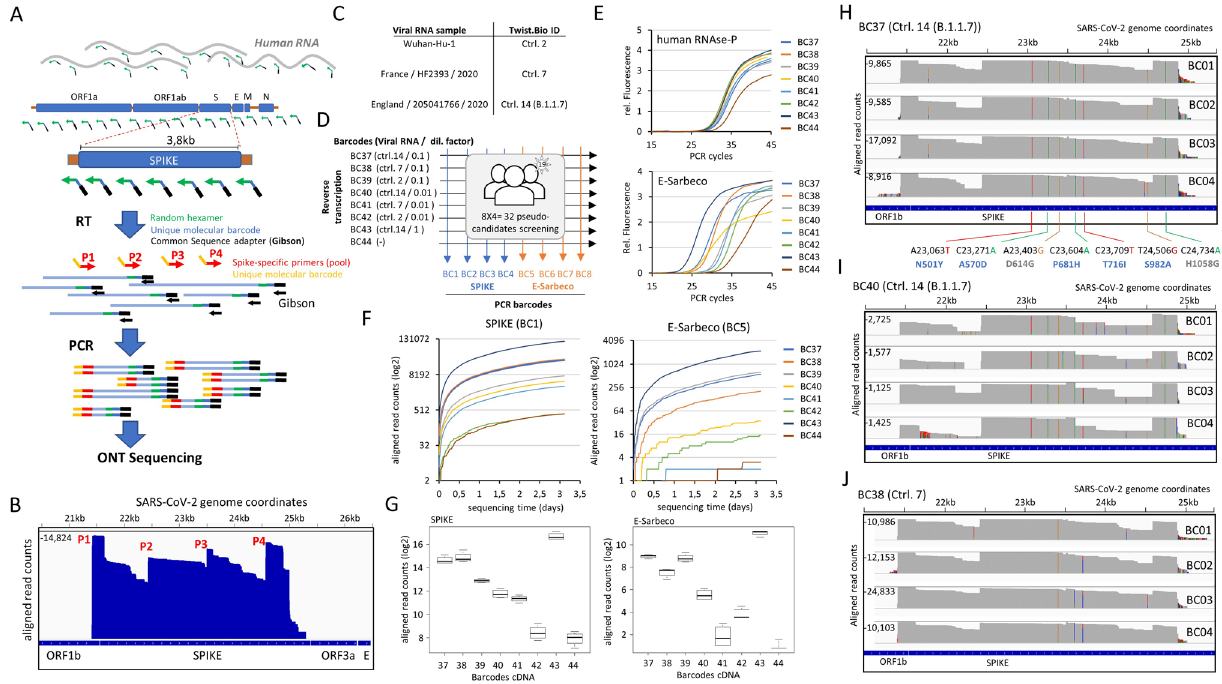
Figure 4. SARS-CoV-2 variants tracking within the SPIKE gene. ( A ) Scheme illustrating the SPIKE targeted strategy for variants tracking with Oxford Nanopore technology (ONT) sequencing. Reverse transcription is performed with random hexamer primers presenting unique molecular barcodes and the Gibson adapter sequence. This approach, allows to generate cDNA products of variable length covering the whole viral but also the human genome. Barcoded cDNA samples are PCR amplified with four SPIKE-specific primers (each of them including a common molecular DNA barcode and spaced by ~ 1 kb distance) and one Gibson primer targeting the adapter sequence introduced during reverse transcription. For facilitating the assay, all four SPIKE and Gibson primers are used within an equimolar pool. PCR amplified samples are analyzed by Oxford Nanopore MinION DNA sequencing. ( B ) Genome browser view displaying the aligned read counts obtained after ONT sequencing. Location of each of the SPIKE-targeting primers (P1-P4) is displayed and corresponds to regions presenting the highest read counts within the SPIKE gene. ( C ) Summary of the used synthetic SARS-CoV-2 viral RNA samples, corresponding to the Wuhan-Hu-1 control sample (reference strain) and two described variant strains (HF2393 and B.1.1.7). ( D ) Reverse transcription assay scheme for 7 conditions corresponding to different dilutions of viral RNA issued from the strains illustrated in ( C ) (BC37-BC43) and a control sample devoid of viral RNA (BC44). In all cases, 15 ng of human RNA material—issued from cell lines in culture—has been also introduced. All 8 samples are pooled at the end of the reverse transcription assay and PCR amplified with either four pools of barcoded primers targeting the SPIKE gene (BC1–BC4) or four barcoded primers targeting the E-Sarbeco region (BC5–BC8), providing a combinatorial barcoding strategy corresponding to 32 pseudo-candidates. ( E ) Quantitative PCR targeting either the human RNAse-P gene or the viral E-Sarbeco region, performed over the reverse transcription assays described in ( D ). ( F ) Real-time Covid-19 diagnostic performed by RETIVAD displaying the number of aligned read counts per barcoded cDNA sample (described in ( D )) for the gene SPIKE (BC1) or the E-Sarbeco region (BC5). ( G ) Boxplots illustrating the total aligned read counts associated to the gene SPIKE or the E-Sarbeco region for each of the conditions described in ( D ). ( H ) Variant analysis performed by RETIVAD over the barcoded sample 37 (BC37) associated to the corresponding PCR barcodes (BC1–BC4). The displayed genome browser view reveals the presence of multiple nucleotide variants (colored bars), among them seven being retrieved on all four samples (BC1-BC4) and with a significant read coverage. Five of them (A23,063T; C23,271A; C23,604A; C23,709T; T24,506G) correspond to missense mutations that were described within the B.1.1.7 UK variant strain (blue). In addition, two other missense mutations were also detected; the D614G (previously described within SARS-CoV-2 European strains) and the H1058G. ( I ) Similar to (H) but for the sample BC40, corresponding to a tenfold lower RNA titer than that used for sample BC37. Note that the same missense mutations retrieved in (H) are observed (colored bars), and this in despite of the lower aligned read counts. ( J ) Variants detection assay over the sampled BC38, corresponding to the SARS-CoV-2 variant strain HF2393, described in France in 2020. In this case, only the missense mutation D614G is retrieved among all four samples